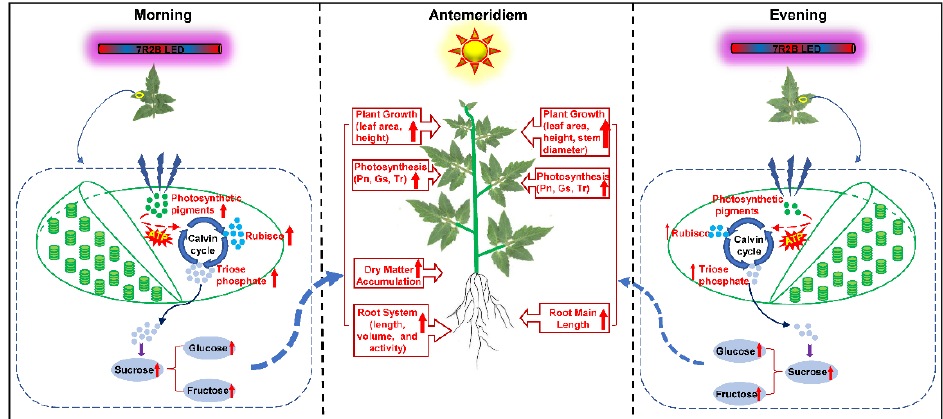
Figure 7. Schematic illustration of the response of tomato plants to red and blue LED light supple- mentation in the morning and evening. Illumination using red and blue LED light in the morning, via the early activation of key photosynthesis-associated enzymes, promoted the synthesis and accu- mulation of photosynthetic pigments, ultimately increasing the photosynthetic activity and synthesis of photosynthates and promoting root growth and dry matter accumulation in tomato plants. Red arrows represent increase, and the thicker the arrow, the greater the increase.